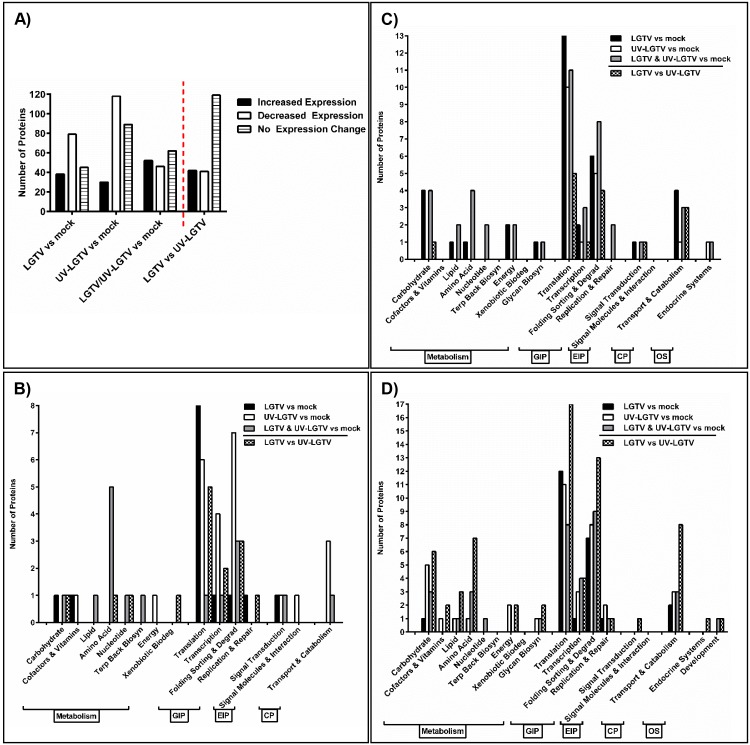
ISE6 proteins identified in KEGG pathways with differential expression following LGTV, UV-LGTV and mock treatment.(A) Total number of ISE6 cell proteins categorized by treatment and change in expression (increase/decrease/no change). Total number of proteins showing (B) increased expression, (C) decreased expression, and (D) no change in expression following LGTV infection and UV-LGTV treatment as compared to mock-treated cells and in LGTV-infected cells as compared to UV-LGTV-treated cells. Proteins were categorized by the KEGG classes for cellular function: metabolism, genetic information processing (GIP), environmental information processing (EIP), cellular processes (CP), and organismal systems (OS).